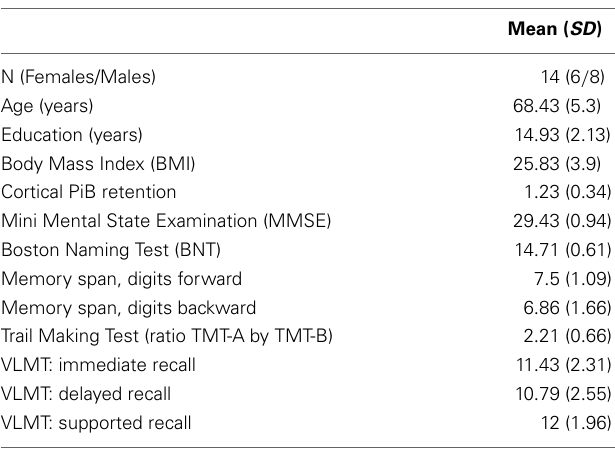
neuropsychological test